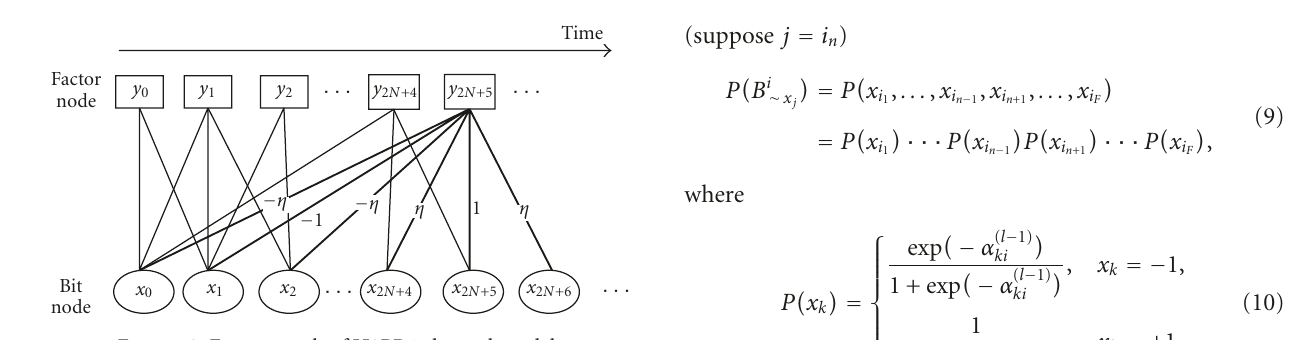
Figure 2: Factor graph of H2PR4 channel